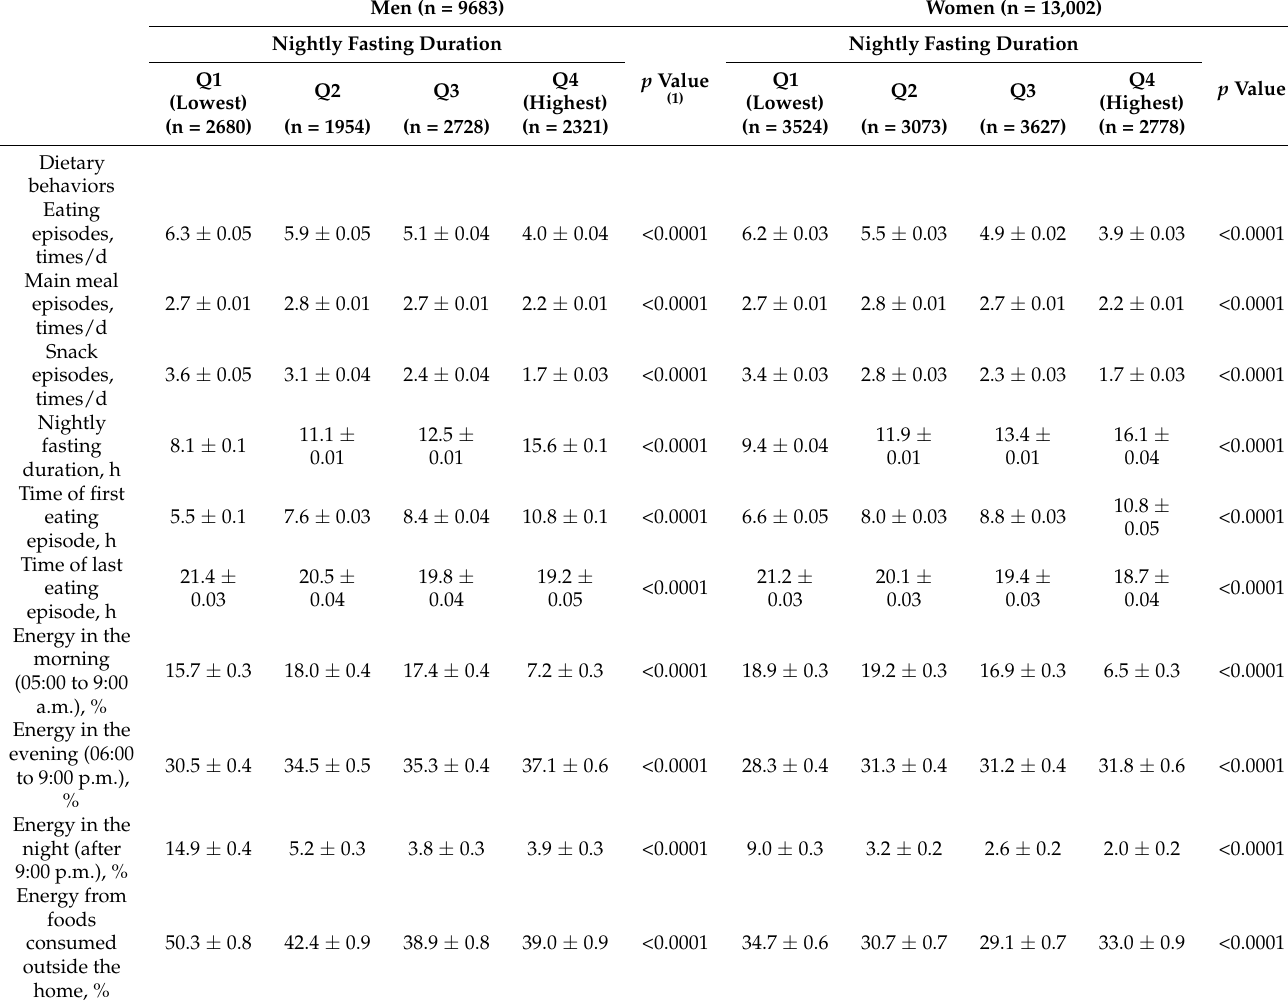
Table 3. Dietary behaviors of study participants based on quartiles of nightly fasting duration in Korean adults. Men (n = 9683) Women (n = 13,002) Nightly Fasting Duration